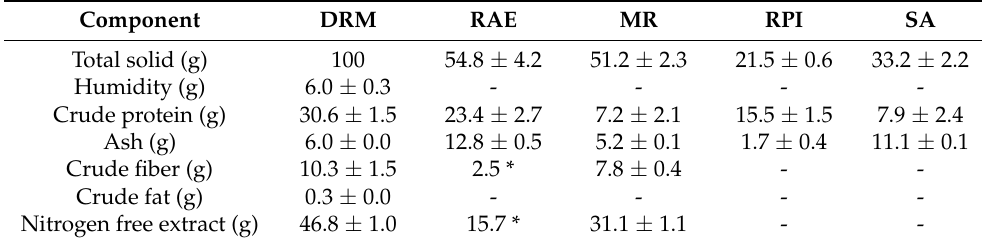
Figure 1. Protein extraction workflow. Table 1. Proximate composition (g/100 g wet matter) of DRM and the recovered